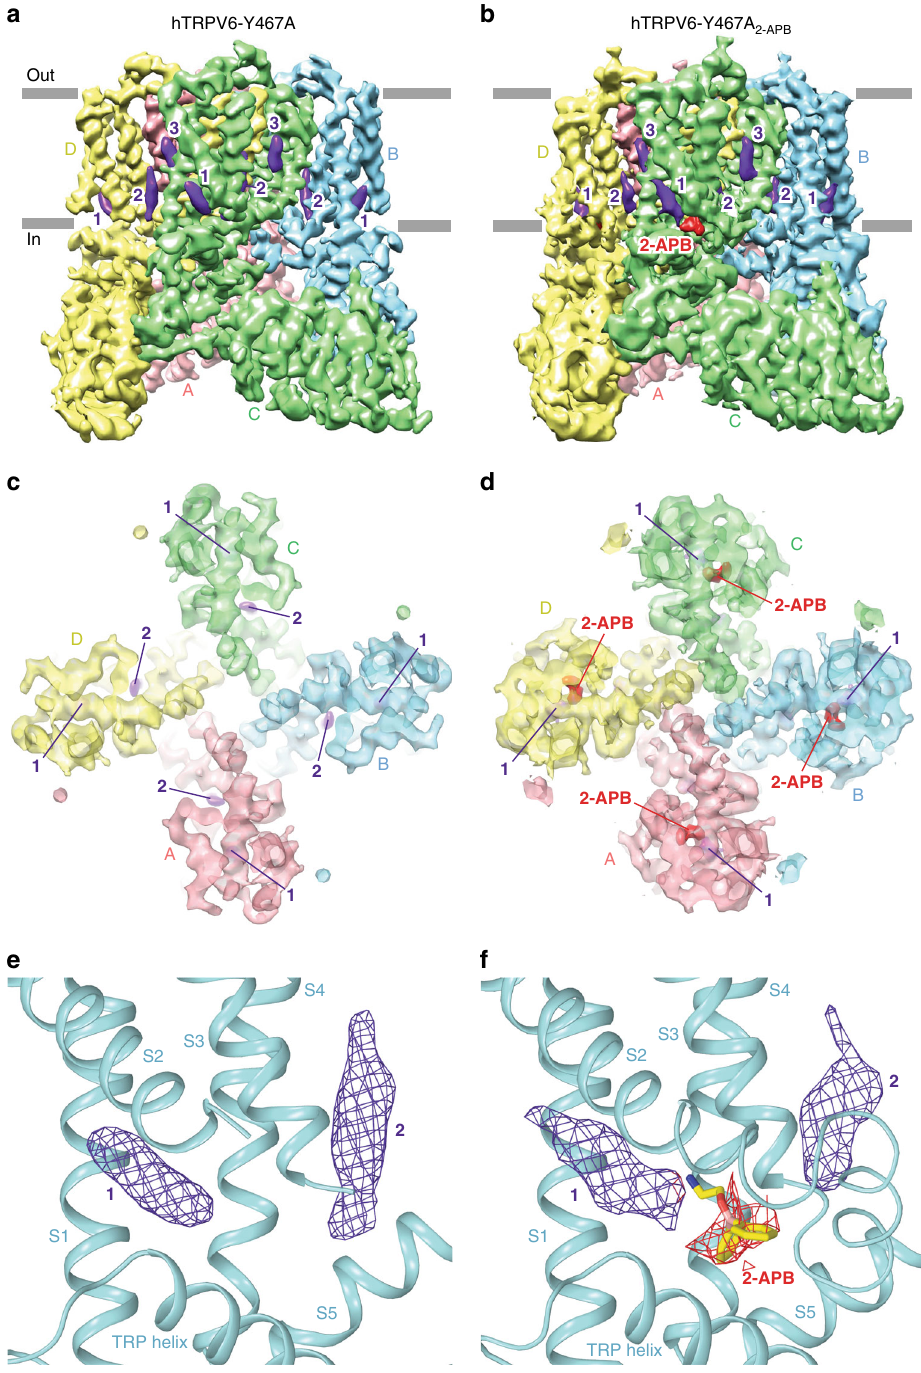
Fig. 6 Open and 2-APB-bound closed cryo-EM structures of human TRPV6. a , b 3D reconstructions of hTRPV6-Y467A ( a ) and hTRPV6-Y467A 2-APB ( b ) viewed parallel to the membrane, with cryo-EM density for hTRPV6 subunits colored pink, cyan, green, and yellow; lipid in purple and 2-APB in red. c , d Semi-transparent cryo-EM density for the ion channel in open hTRPV6-Y467A ( c ) and closed hTRPV6-Y467A 2-APB ( d ) viewed intracellularly. e , f Close-up views of the binding pocket of 2-APB (yellow) in hTRPV6-Y467A ( e ) and hTRPV6-Y467A 2-APB ( f ). Red and purple mesh shows cryo-EM density for 2-APB and lipids,